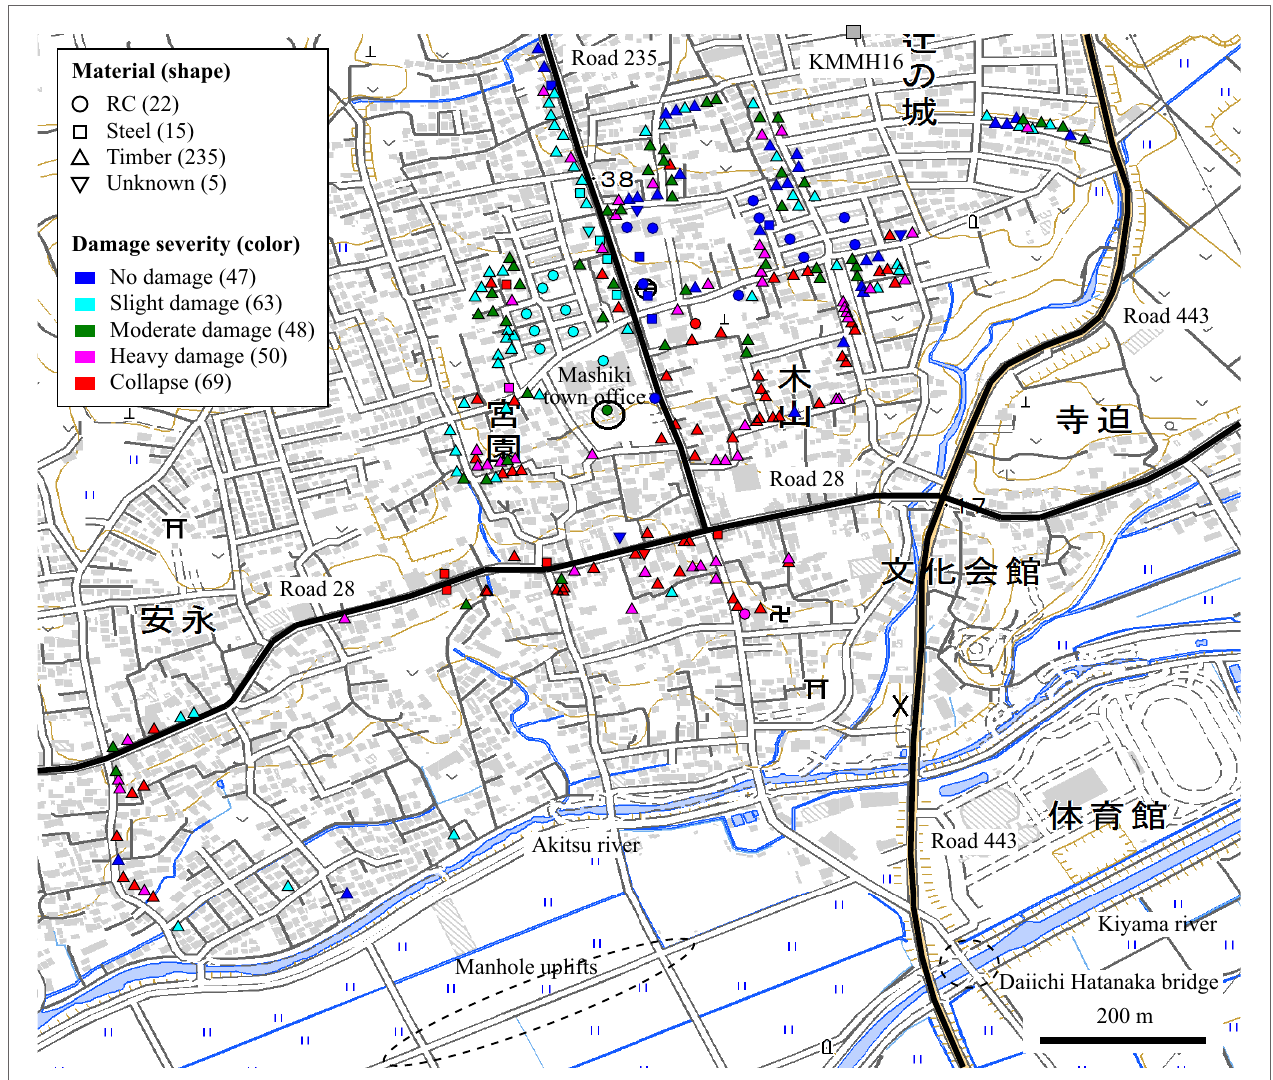
FigUre 15 | Damage survey results in Mashiki Town . The base map was obtained from the Geospatial Institute of